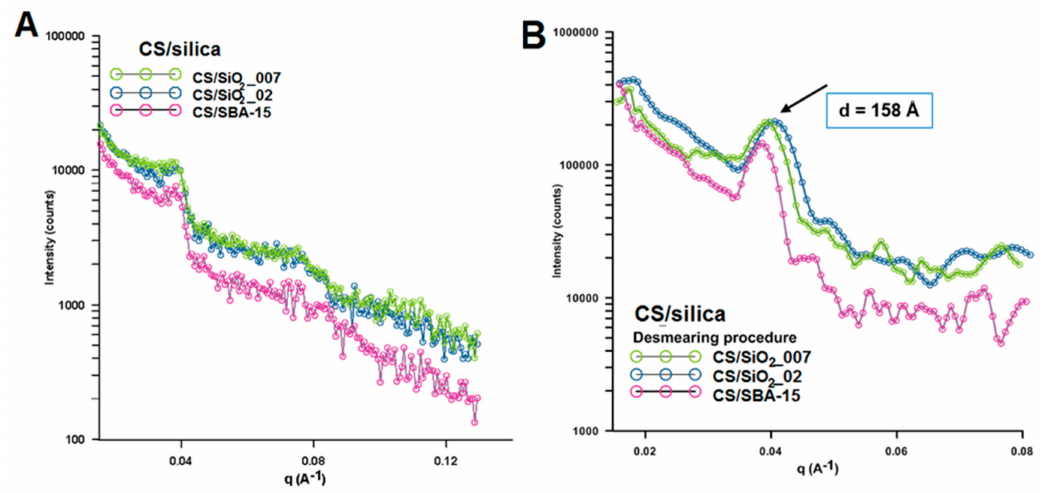
Figure 4. ( A ) Experimental SAXS profiles for CS / silica nanocomposites, ( B ) Experimental SAXS profiles after